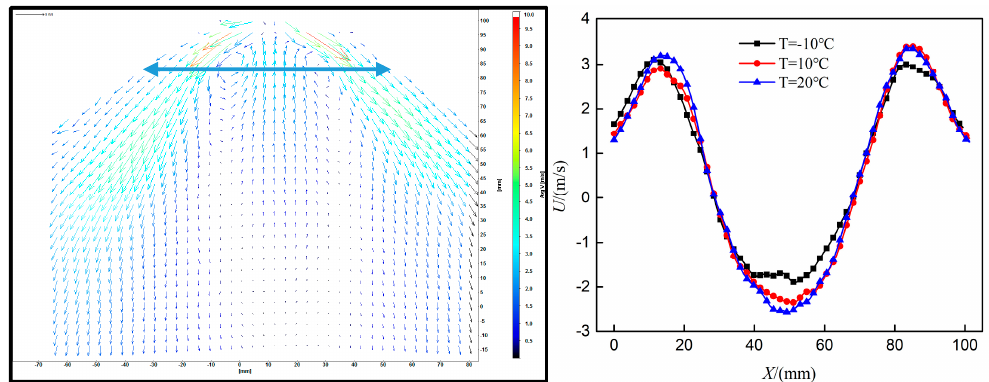
Figure 8. The influence of fuel temperature on the axial velocity ( U ) at a distance of 20 mm from the swirler exit in the y -direction (Case A).